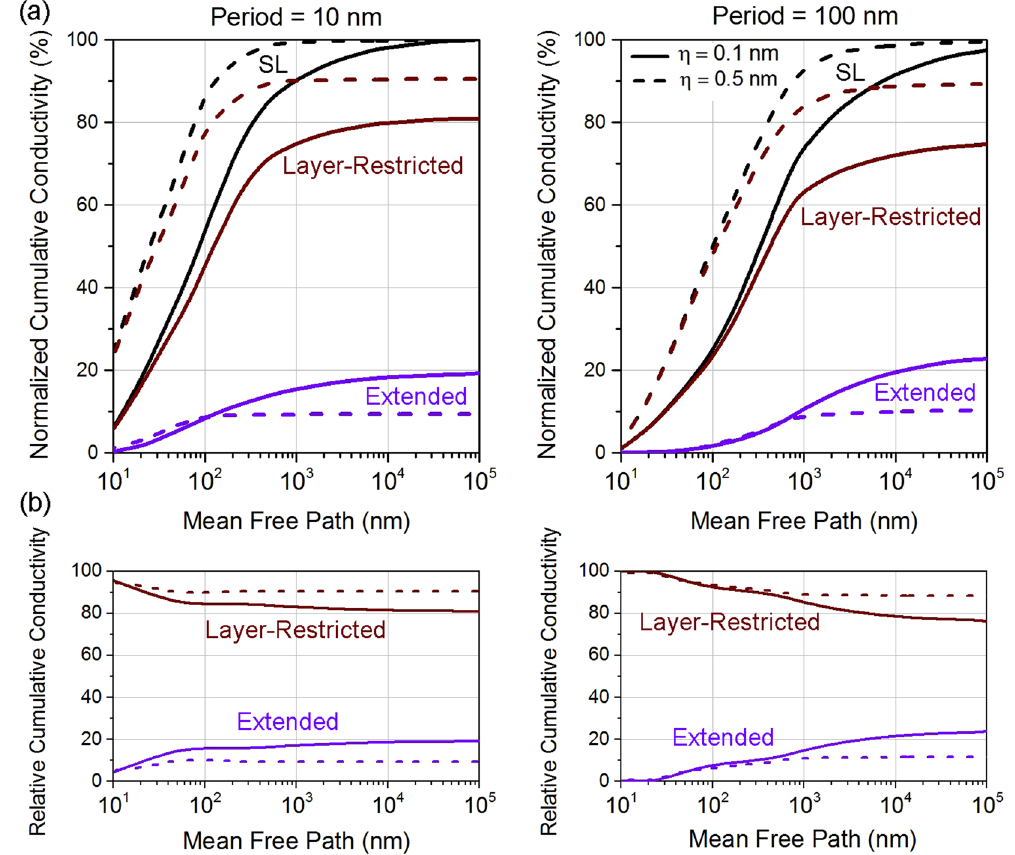
Figure 7. ( a ) Mean-free-path spectrum for Si/Ge SL of period lengths d = 10 nm and 100 nm at roughness values of 0.1 nm and 0.5 nm (solid and dashed curves respectively). ( b ) Relative cumulative contribution of extended and layer-restricted phonons (purple and brown respectively) as a function of mean-free-path in the corresponding SLs.